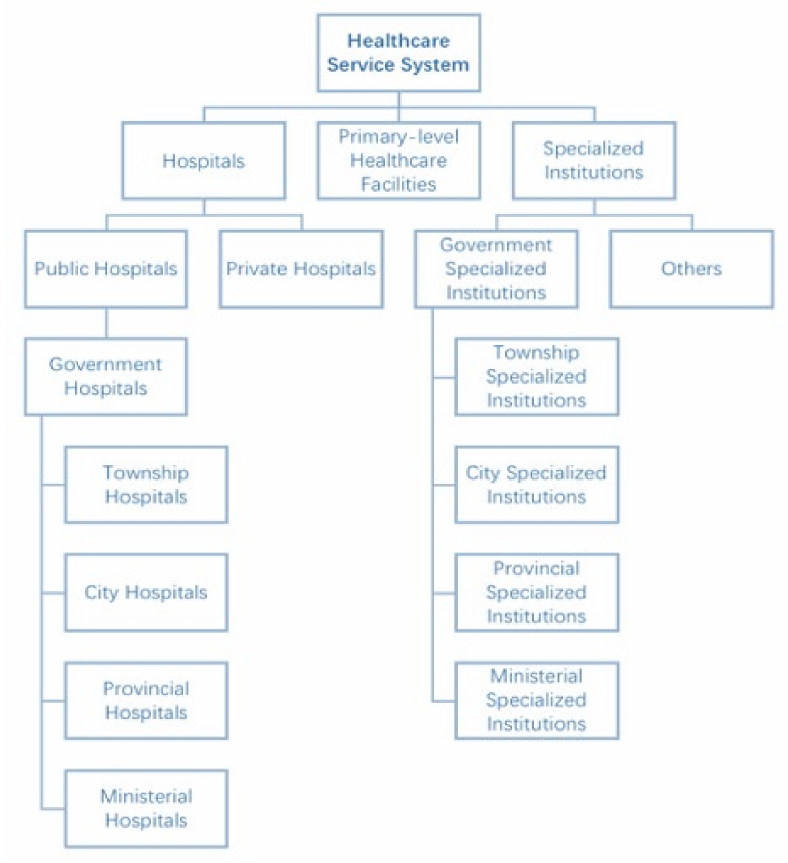
Figure 1. Organization of the healthcare service system in China. (Adapted from source: NHC data